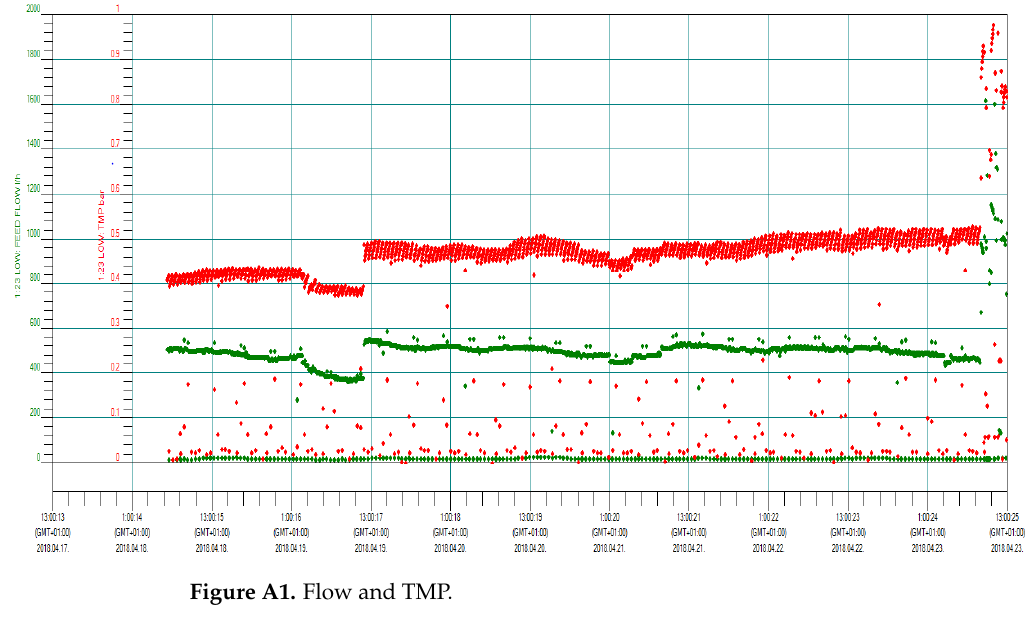
Water 2023 , 15 , x FOR PEER REVIEW Figure A1. Flow and TMP. Figure A1. Flow and TMP.